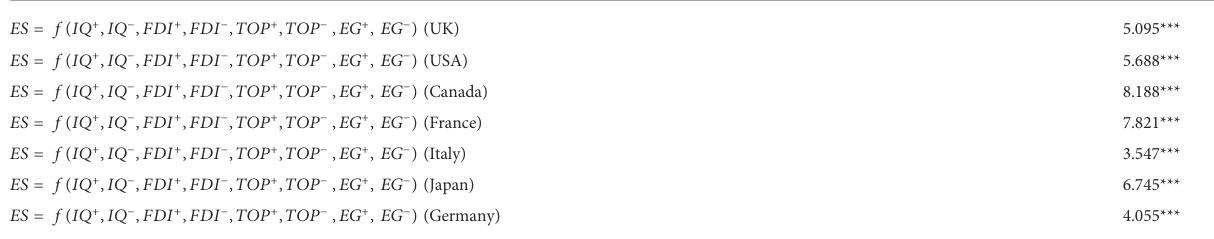
TABLE 4 Bounds test for nonlinear/asymmetric/hidden cointegration. Models